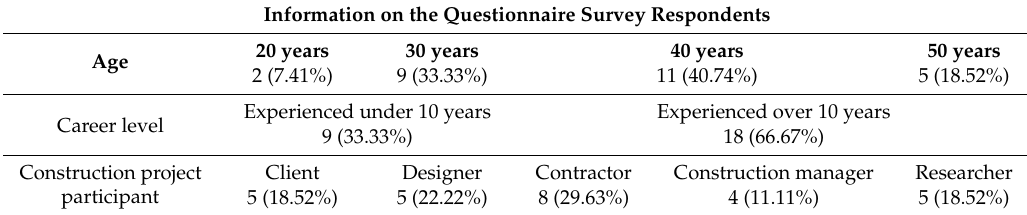
Table 2. Information on the questionnaire survey